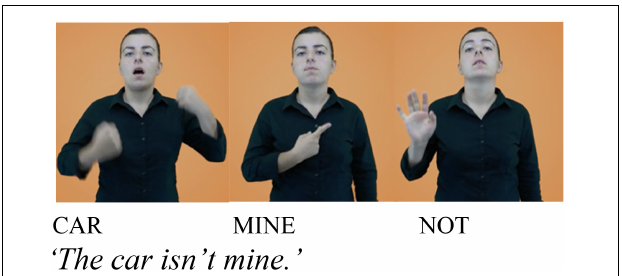
FIGURE 2 | Adapted from Makaro˘glu and Dikyuva (2017, entry: “de˘gil”). Open-source image available from the online T˙ID dictionary: